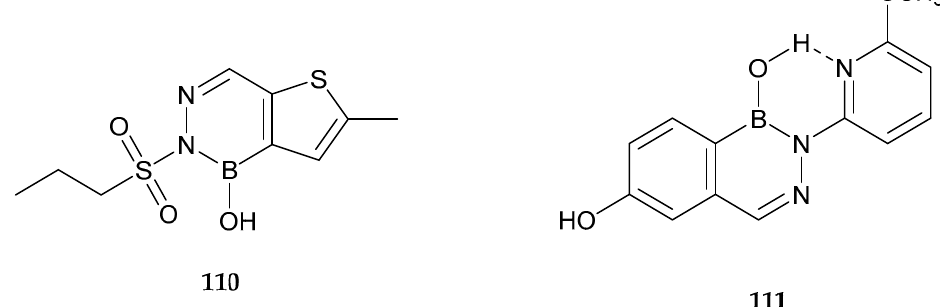
Figure 11. Examples of bioactive diazaborines. 110 , compound with antibacterial activity; 111 : Compound with anticancer activity.